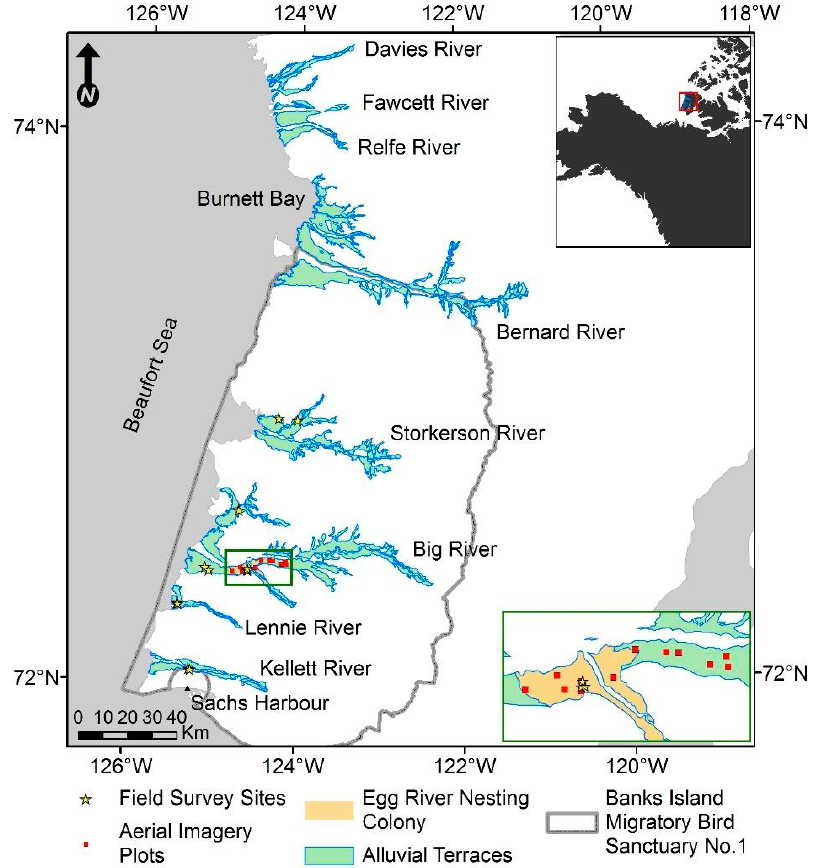
Figure 1. A map of the study area on Banks Island, Northwest Territories, showing field survey sites and areas where fine-scale imagery was analyzed. The inset map in the upper-right corner shows Banks Island as the westernmost island in the Canadian Arctic Archipelago. The inset map in the bottom-right corner is an enlarged map of the nesting colony area, within the Big River valley.